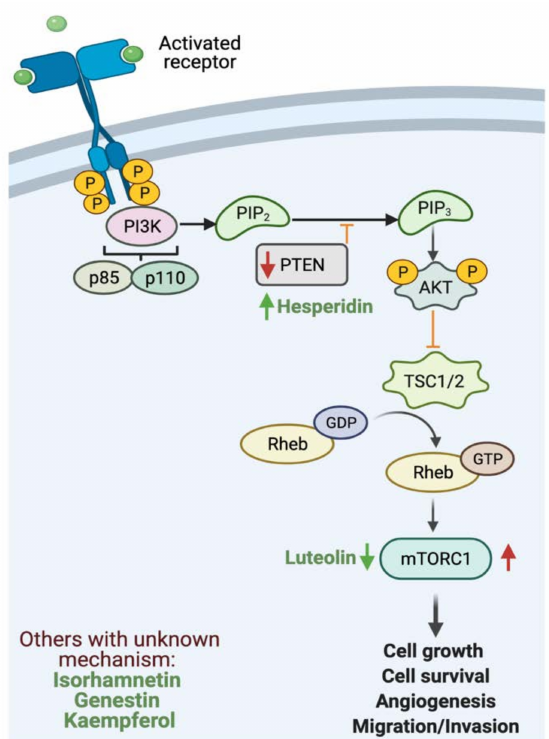
Figure 4. Schematic illustration of the impact of flavonoids on cellular proliferation. The figure illustrates PI3K pathway. Red arrows represent the effects of GI cancer on the pathway, while the green arrows for flavonoids effect. Adapted from “PI3K/Akt, RAS/MAPK, JAK/STAT signaling”, by BioRender.com (accessed on 3 August